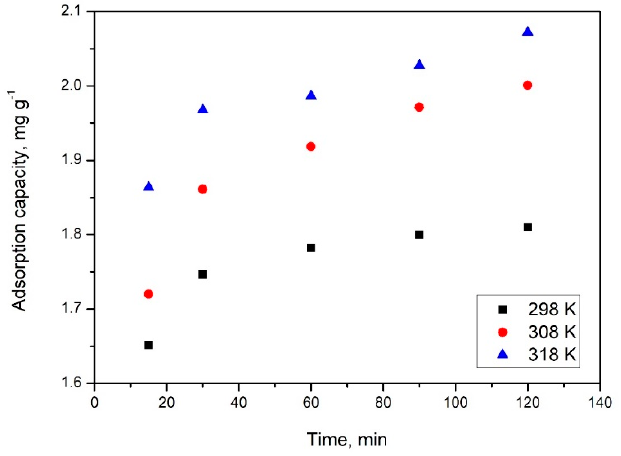
Figure 10. Contact time and temperature influence on adsorption capacity.